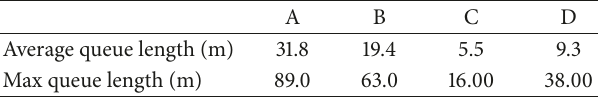
Table 4: Queue lengths measured for each entry of Cosmai Round-